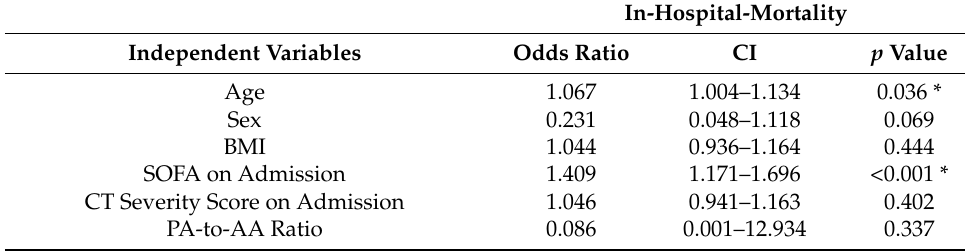
Table 2. Predictors for In-Hospital Mortality for COVID-19 ICU patients (n = 75). Results from binary logistic regression analysis with adjustment for multiple covariates. COVID-19, coronavirus disease 2019; CI, confidence interval; ICU, intensive care unit; BMI, body mass index; SOFA, sequential organ failure assessment; CT, computed tomography; PA, pulmonary artery; AA, ascending aorta; and * statistically significant ( p < 0.05).